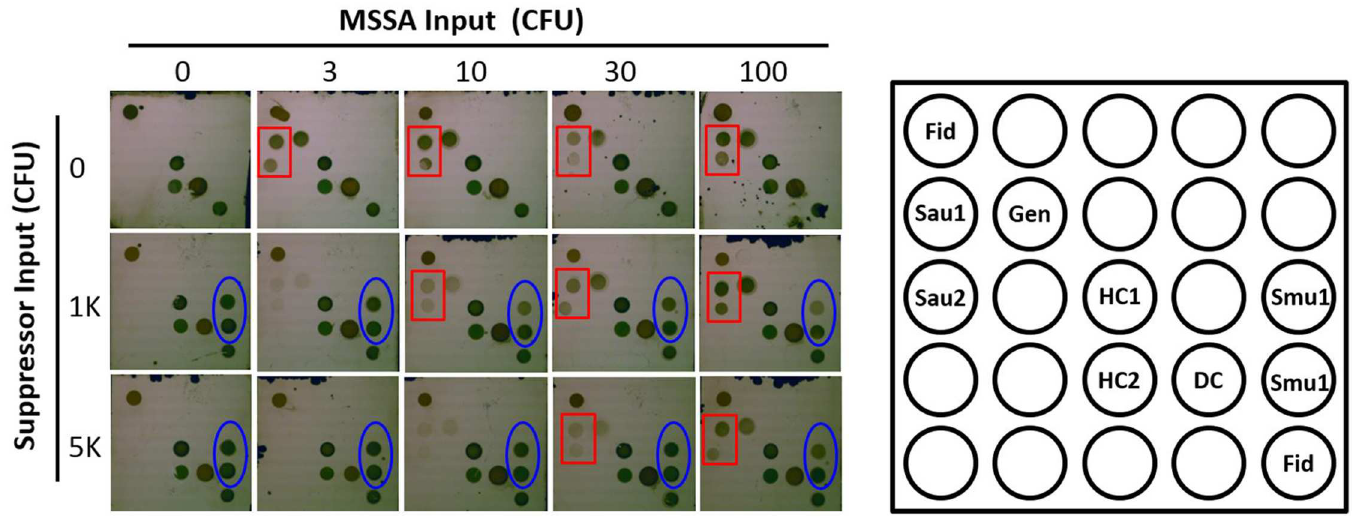
Fig 3. Effect of suppressor input on the limit of detection for MSSA. Staphylococcus muscae cells are used to suppressthe low copy amplification of the tuf gene using primer pair tuf430L/tuf527v1. The probe map is shownin the right panel. Fid = Fiducial control; HC = Hybridization control; DC = Detection control, Gen = Staphylococcus genusprobe, Sau = Staphylococcus aureus specific probe; Smu = Staphylococcus muscae .Others are blank or irrelevant species probes. The red rectanglesindicate the Staphylococcus aureustuf specific probe reacted, generatingdetectablesignal. The blue ovals show the detectablesignal with the suppressor( Staphylococcus muscae ) specific probe.